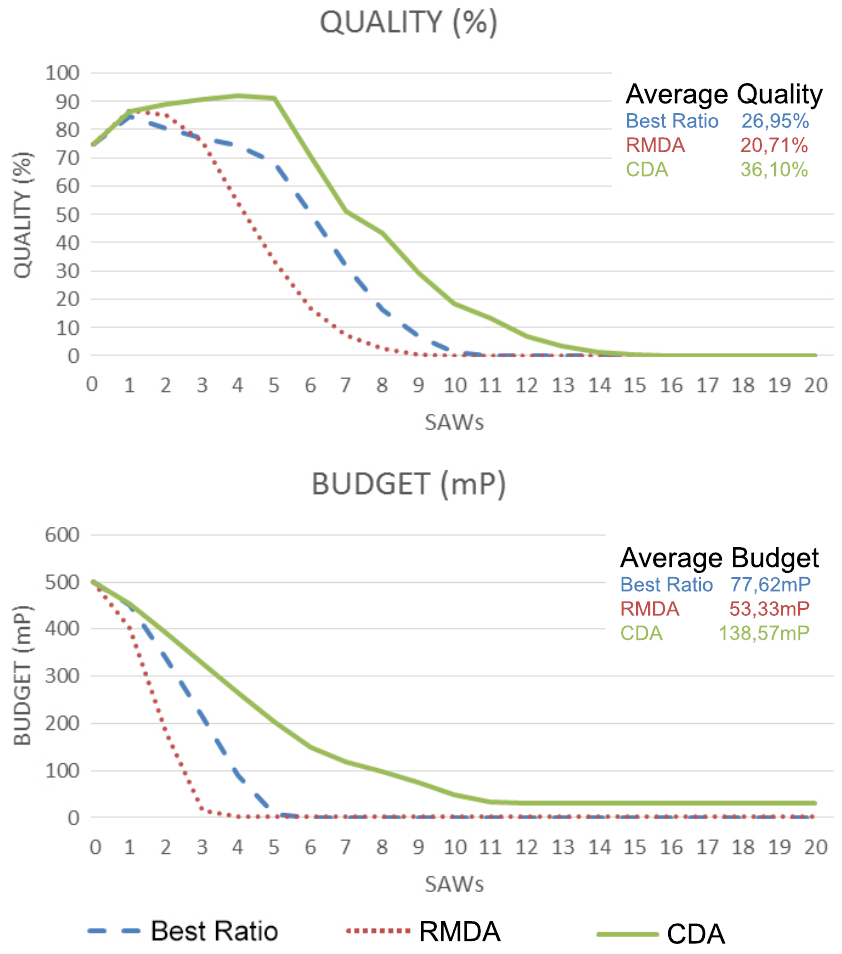
Figure 4. Auction-based comparison results under low budget